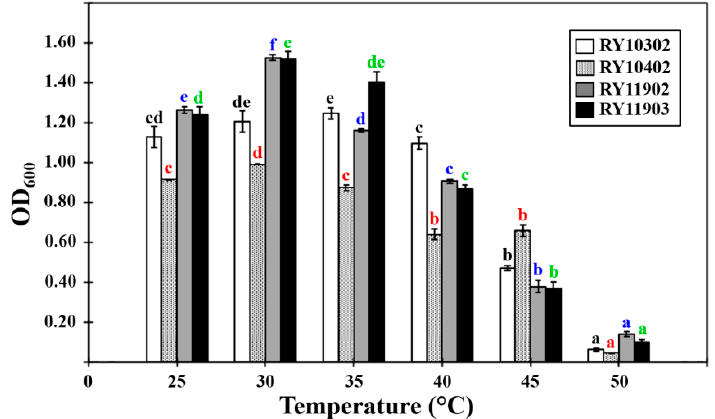
Figure 3. Effect of temperature on the growth of four dye-decolorizing bacteria expressed as optical density measured at 600 nm. All experiments were performed in triplicate. Different letters with the same color on the top of SD bars indicate significant differences ( p < 0.05).